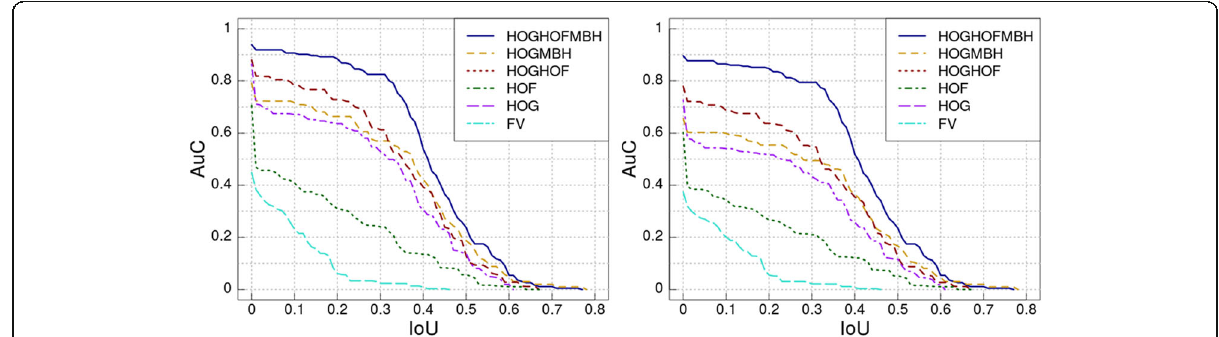
Fig. 7 Mean AuC over all interactions using four-fold cross-validation in the SC (left) and MC (right) scenarios of